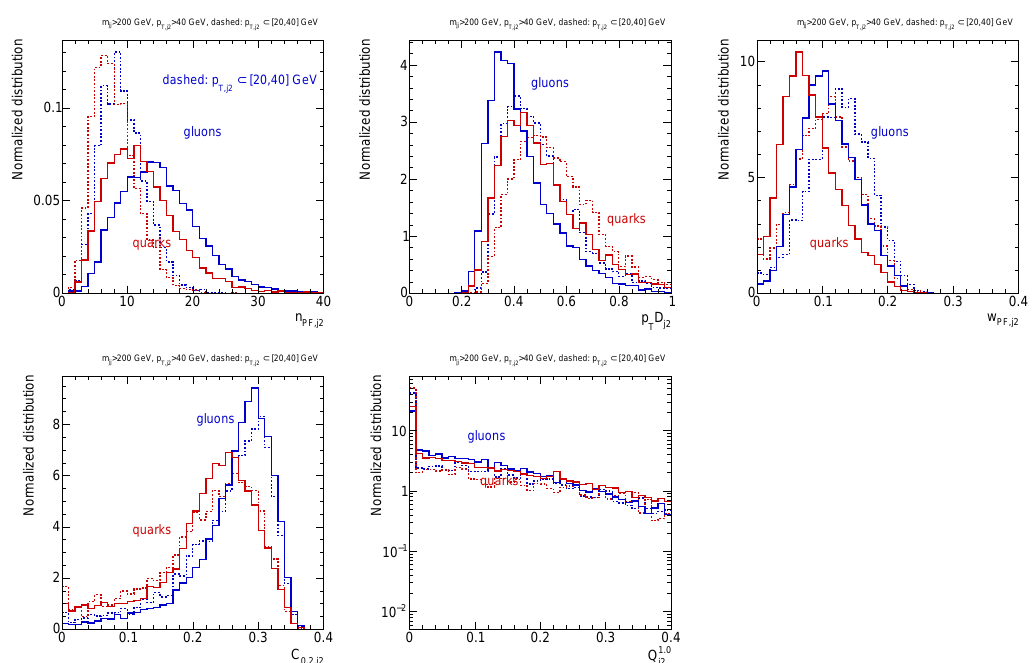
Figure 8: Distribution of the quark vs gluon discrimination variables listed in Eq.(8) for the second jet in a pure QCD Z j j sample. We show partonic two-quark and > 200 GeV combined with the two slices two-gluon final states requiring m jj = 20 ... 40 GeV and p > 40 p T , j 2 T , j 2